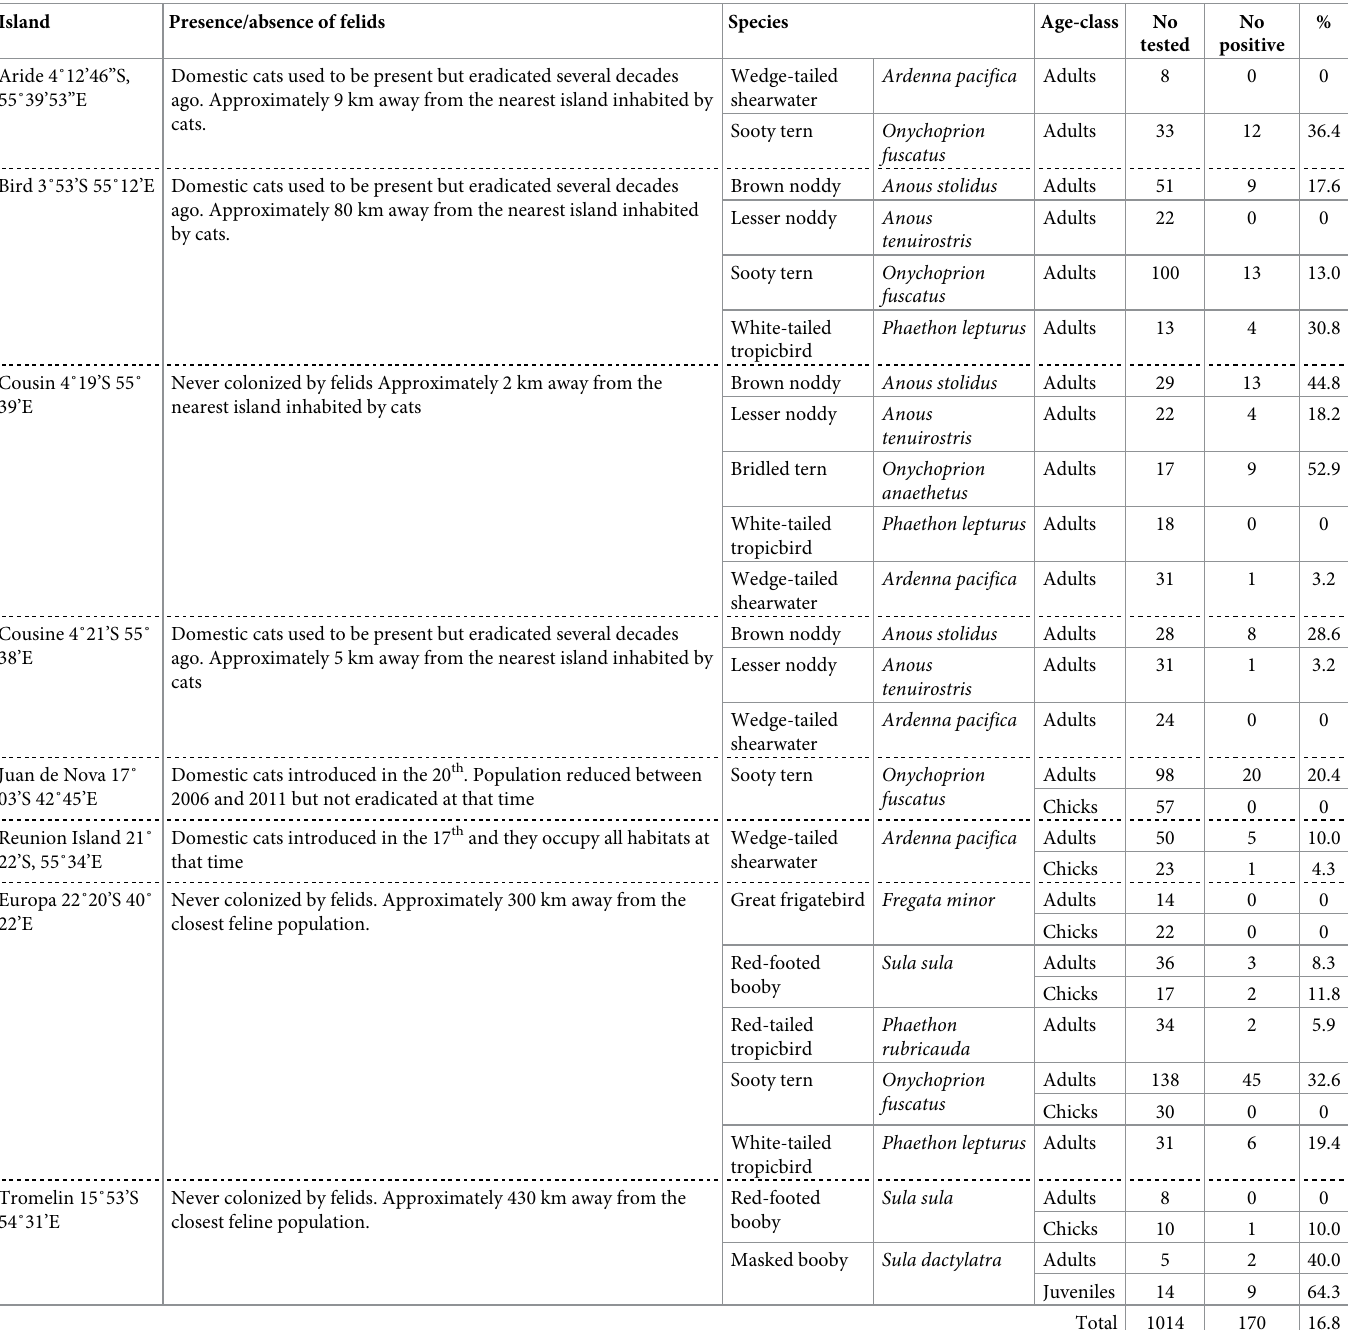
Table 1. Information on the 1014 seabirds sampled in the Western Indian Ocean between 2011 and 2015 whose sera were tested for the detection of Toxoplasma gondii antibodies (MAT � 10).